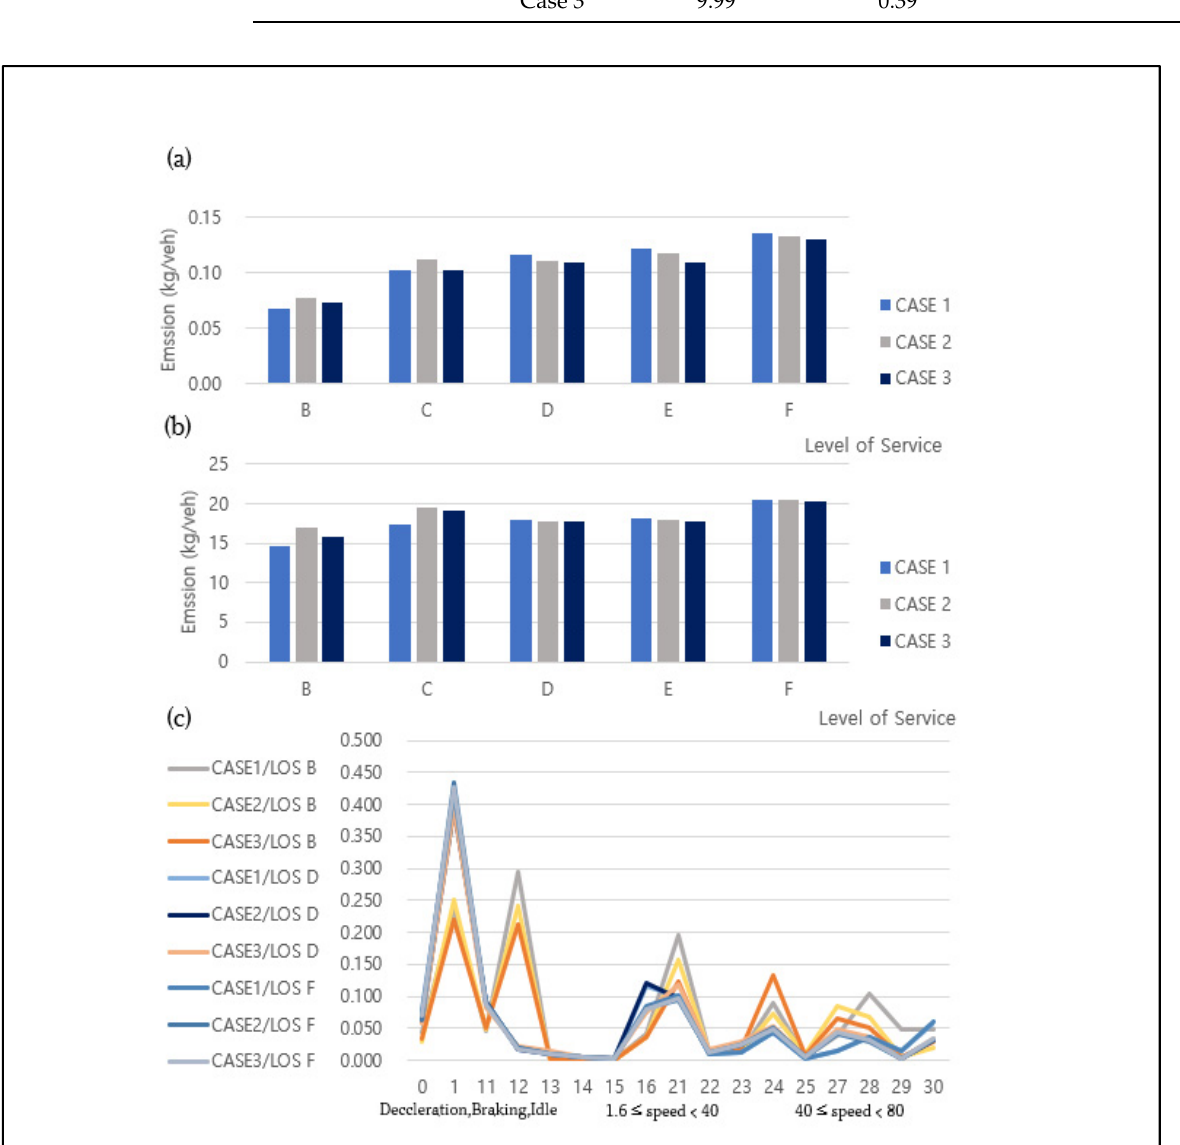
Figure 5. Emission comparison: ( a ) NOx, ( b ) CO 2 , and ( c ) operating mode bin distributions by scenario.